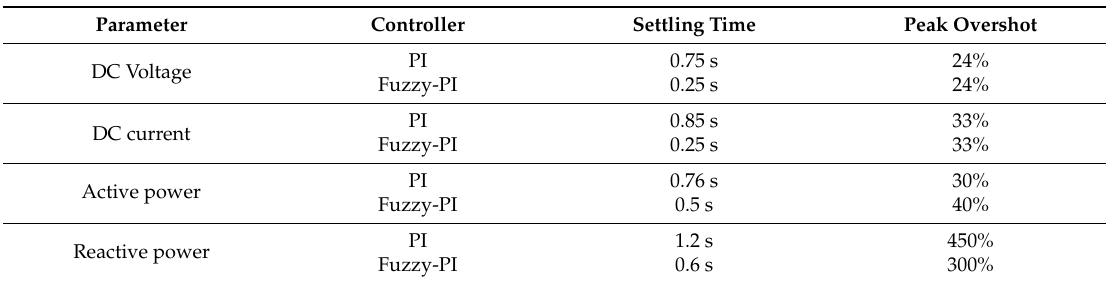
Table 2. Comparative performance of the used controllers.